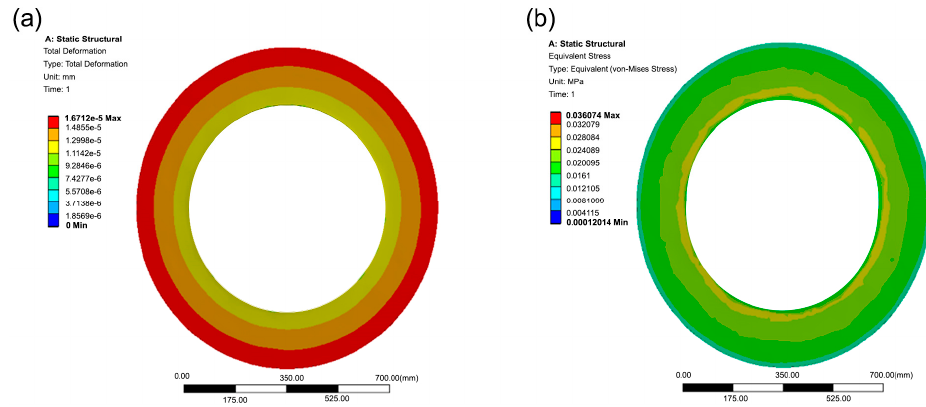
Figure 3. Static structural simulation of the coating; ( a ) total distortion, ( b ) equivalent stress.